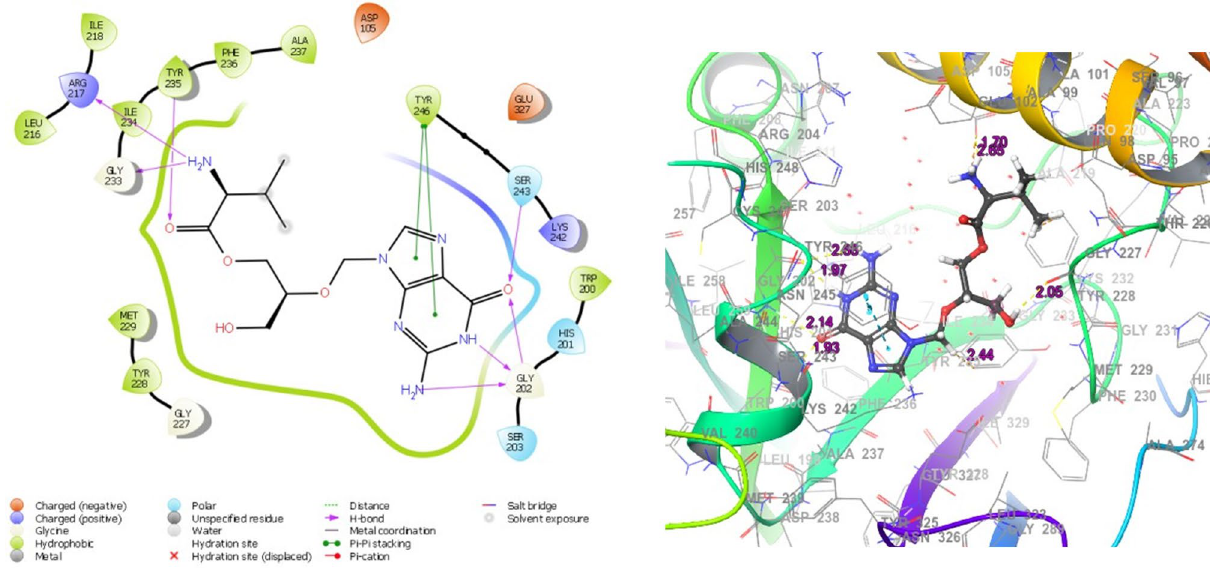
Figure 3. Binding poses of valganciclovir in poly [ADP-ribose] polymerase 1, PARP1(3L3M) (The 2D and 3D interaction diagrams from Schrodinger Maestro 11.2 GUI 36 , it gives the possible binding modes and the corresponding bond